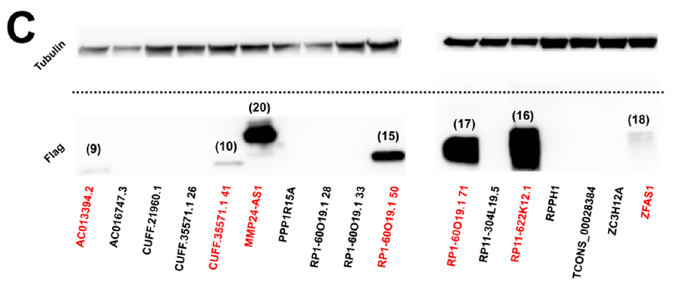
Figure 3. A subset of the micropeptides can be ectopically expressed upon transient transfection. ( A ) qPCR results for various lncRNAs corroborate the findings of RNA-seq. Error bars represent the standard deviation from three independent experiments (Table S2). All data were normalized to actin. ( B ) Bar graphs representing the percent of cells expressing FLAG peptide or GFP upon transient transfection. GFP expression indicates that the mRNA is produced and translated, while the FLAG signal represents the percent of cells with detectable levels of micropeptide. ( C ) Protein blot analysis shows that a subset of the micropeptides can be stably expressed and the band sizes (numbers above the bands, in kD) are in line with estimates from the ribosome profiling data (Table S1). Genes 2017 , 8 , 206